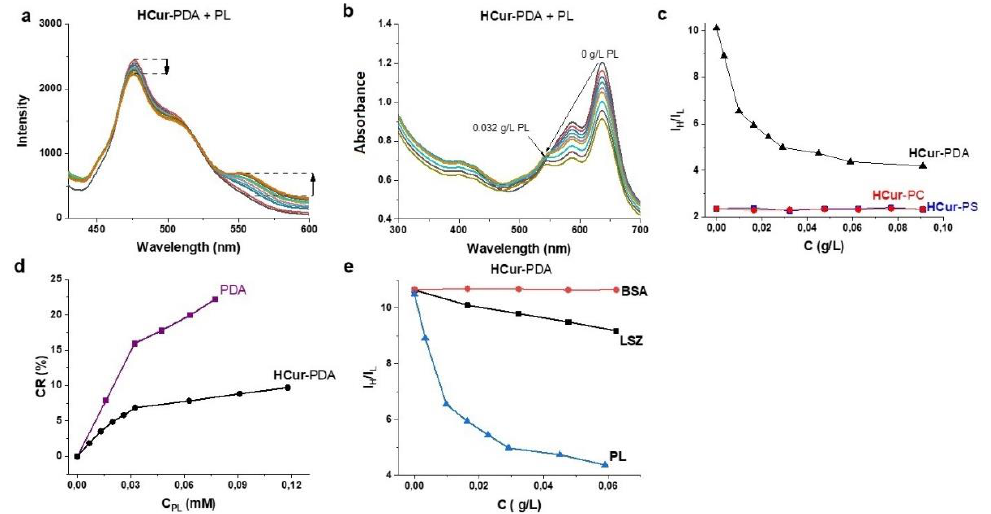
Figure 6. Luminescence ( a ) and electronic absorption spectra ( b ) of HCur -PDA at different concentrations of PL (from 0 to 0.091 g/L). ( c ) I H /I L of HCur -PC, HCur -PS and HCur -PDA vs. concentration of PL (from 0 to 0.091 g/L). ( d ) Colorimetric response of PDA and HCur -PDA to different concentrations of PL. ( e ) I H /I L of HCur -PDA at different concentration of PL, LSZ and BSA.